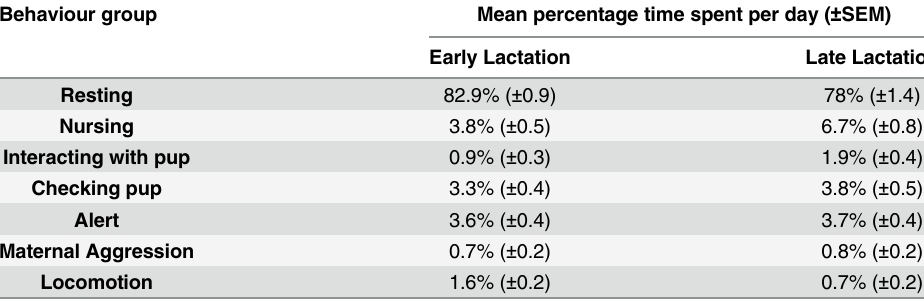
Table 3. The seven behaviour groups for grey seal mothers and mean percentage time recorded per day for each behaviour group in early and late lactation ( ±